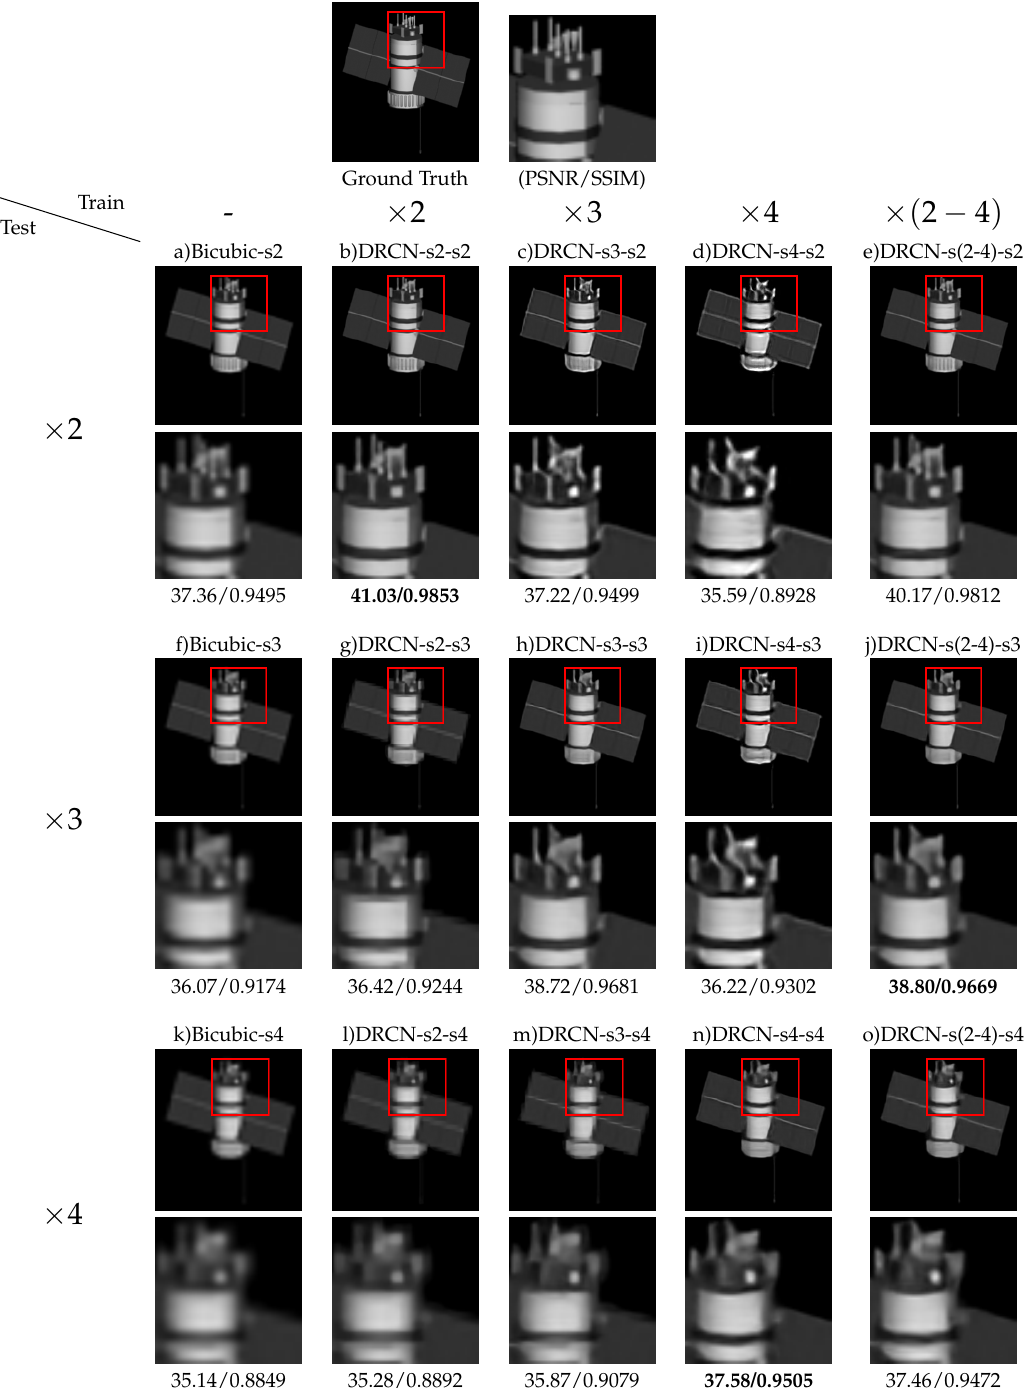
Figure 6. Scale factor experiment for “glonas” in BUAA-SID 1.0. The method sm method is trained for